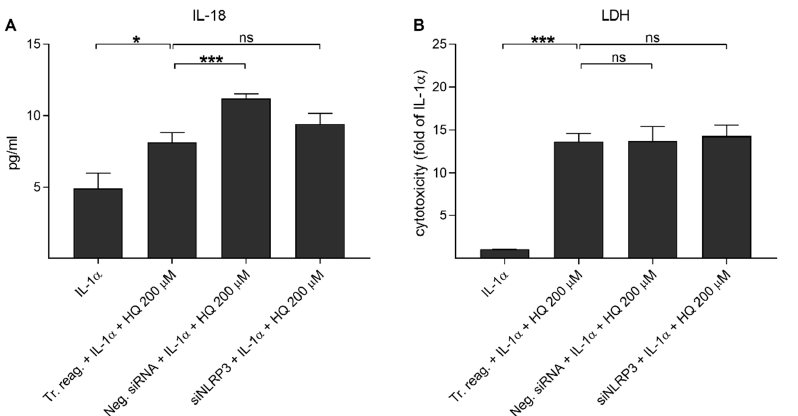
Figure 5. The effect of 200 μ M hydroquinone (HQ; 18 h) on the IL-18 secretion ( A ) and on the intracellular NLRP3 level ( B ) in unprimed ARPE-19 cells. An untreated control group was used as the control for hydroquinone treatment. IL-18 concentrations in medium samples ( A ) were 4.552–10.556 pg/mL in the control and 32.132–123.617 pg/mL in the HQ 200 μ M group. Absorbance values in ( B ) were 0.443–0.563 in the control and 0.345–0.579 in the HQ 200 μ M group. Data were combined from two independent experiments containing four ( A ) or two ( B ) parallel samples per group. Results are shown as mean ± SEM. *** P < 0.001, ns—not significant, Mann-Whitney U-test.